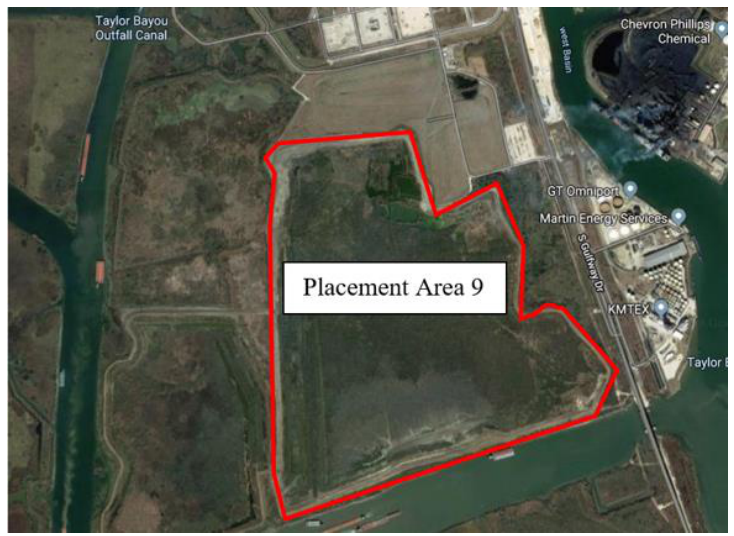
Figure 1. Sabine-Neches Waterway Placement Area 9 (Latitude: 29.82821, Longitude: − 93.97543) [23].